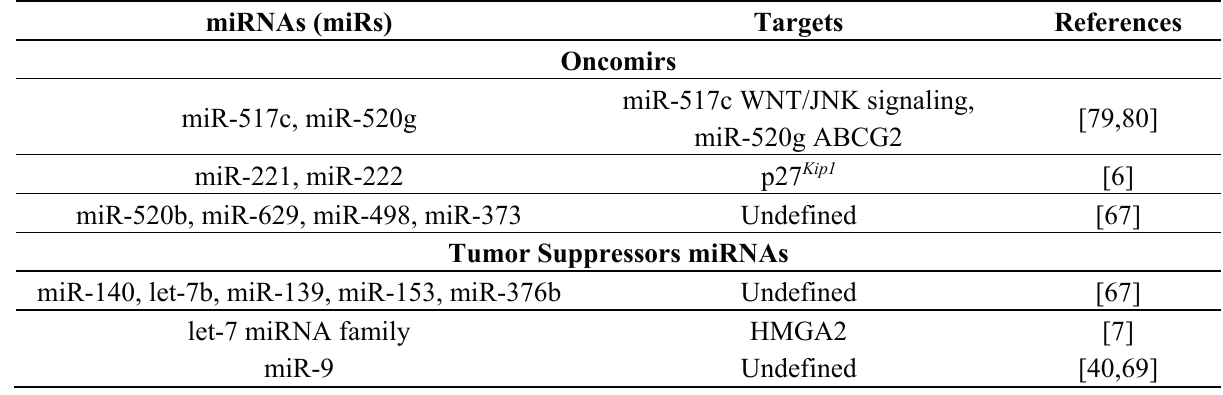
Table 2. miRNAs involved in atypical teratoid/rhabdoid tumors (AT/RT) biology as oncogenes or tumor